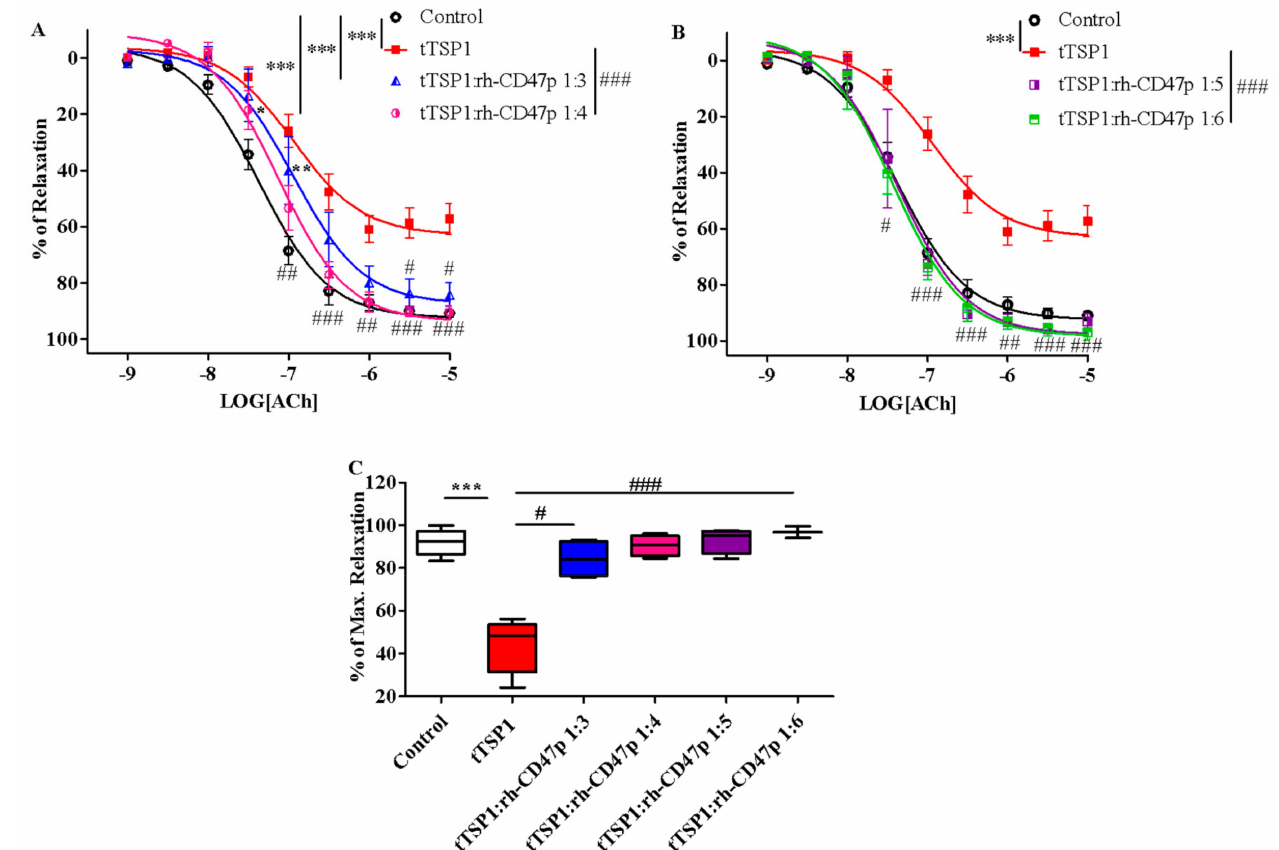
Figure 6. Post-treatment with recombinant human CD47 peptide (rh-CD47p) in low and high molar ratios differentially restored trimeric TSP1 (tTSP1)-blunted vasodilation. Acute exposure to tTSP1 for an initial 15 min was followed by 45 min coincubation with rh-CD47p. ( A ) Concentration-response curves of isolated mouse thoracic aorta exposed to tTSP1 alone or the combination of tTSP1 and rh-CD47p in low molar ratios (tTSP1:rh-CD47p 1:3 and 1:4). Low doses of rh-CD47p post-treatment ameliorated tTSP1-impaired vasodilation with limited efficacy (two-way ANOVA followed by a Bonferroni posthoc test; n = 3, * p < 0.05, ** p < 0.01, *** p < 0.001, tTSP1 alone, tTSP1:rh-CD47p 1:3 or 1:4 vs. control; # p < 0.05, ## p < 0.01, ### p < 0.001, tTSP1:rh-CD47p 1:3 or 1:4 vs. tTSP1). ( B ) Concentration-response curves of isolated mouse thoracic aorta exposed to tTSP1 alone or the combination of tTSP1 and rh-CD47p in high molar ratios (tTSP1:rh-CD47p 1:5 and 1:6). A total reversion of tTSP1-injured vasodilation was consistently observed in rh-CD47p post-treatment in high molar ratios (two-way ANOVA followed by a Bonferroni posthoc test; n = 4, *** p < 0.001, tTSP1 vs. control; # p < 0.05, ## p < 0.01, and ### p < 0.001, tTSP1:rh-CD47p 1:5 or 1:6 vs. tTSP1). ( C ) Percentages of maximal relaxation in response to 10 µ M acetylcholine are presented as box and whisker plots showing median, 1st quartile, 3rd quartile, and 95% CI. Significantly reduced vasorelaxation observed in tTSP1-treated alone no longer existed after receiving low or high doses of rh-CD47p treatment ( n = 3–4, *** p < 0.001, tTSP1 vs. control; # p < 0.05, tTSP1:rh-CD47p 1:3 vs. tTSP1; ### p < 0.001, tTSP1:rh-CD47p 1:4 up to 1:6 vs.